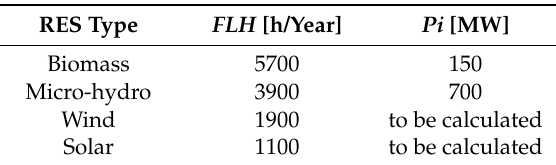
Table 4. FLH and Pi of RES.